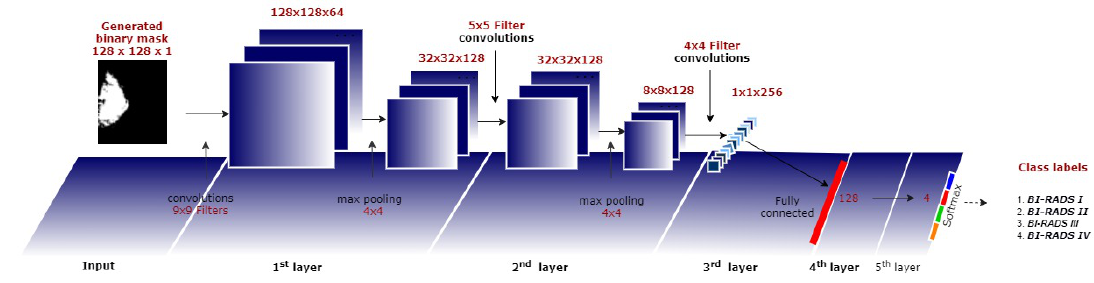
Figure 6. Proposed CNN architecture used for breast density classification (second